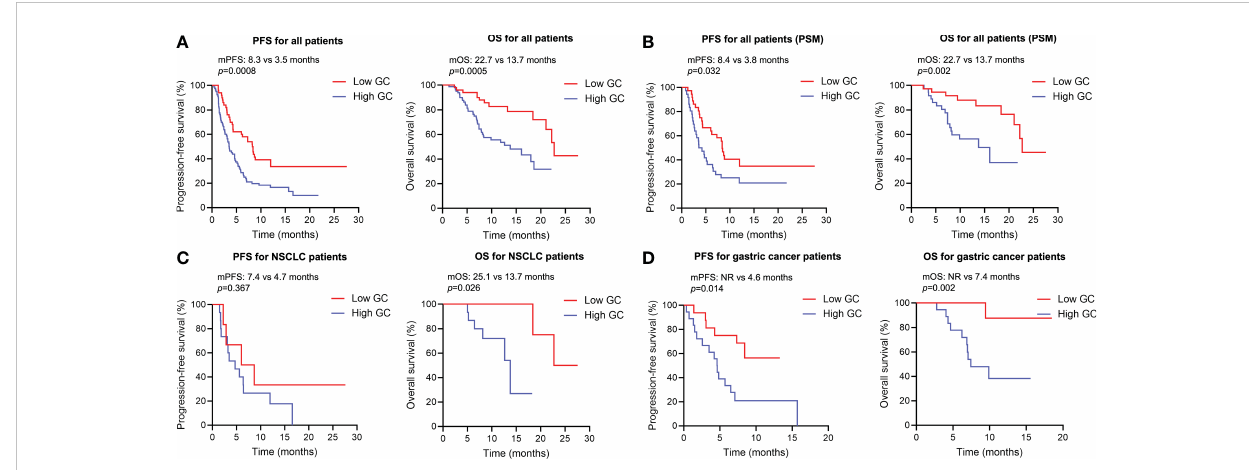
FIGURE 3 Kaplan-Meier survival curves for overall survival and progression-free survival according to the baseline endogenous GC levels. (A) Kaplan-Meier survival curves for progression-free and overall survival according to the baseline endogenous GC levels in all populations (n=130). (B) Kaplan-Meier survival curves for progression-free and overall survival according to the baseline endogenous GC levels in all populations after PSM (n=72). (C) Kaplan-Meier survival curves for progression-free and overall survival according to the baseline endogenous GC levels in NSCLC patients (n=20). (D) Kaplan-Meier survival curves for progression-free and overall survival according to the baseline endogenous GC levels in gastric patients (n=34). PSM, propensity score matching; GC, glucocorticoid; NSCLC, non-small cell lung cancer; mOS, median overall survival time; mPFS, median progression-free survival.